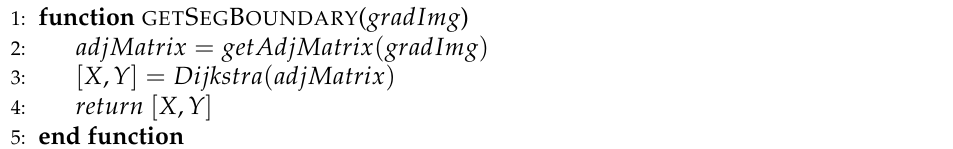
Algorithm 5 Computing layers boundaries by extracting the most prominent bound- ary available.